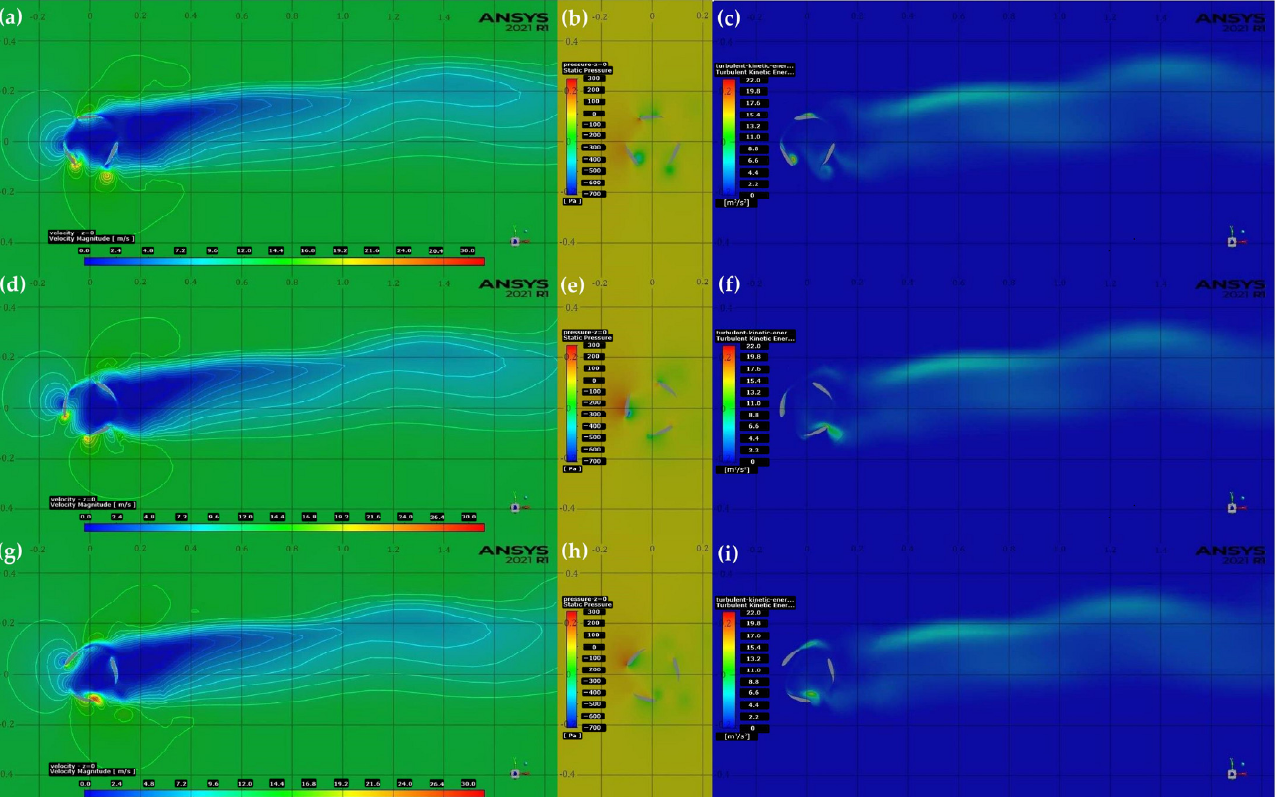
Figure 11. Contours for 14 m/s wind speed at different stages of rotation of: ( a ) Velocity at 360°; ( b ) Pressure at 360°; ( c ) TKE at 360°; ( d ) Velocity at 320°; ( e ) Pressure at 320°; ( f ) TKE at 320°; ( g ) Velocity at 280°; ( h ) Pressure at 280°; ( i ) TKE at 280°. The obtained pressure contours for the wind speed of 14 m/s and TSR of 0.7 at